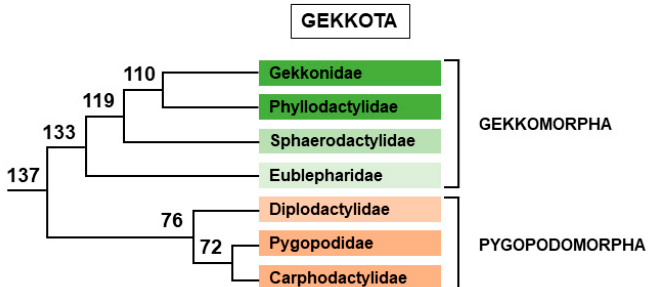
Figure 10. Phylogenic tree of Gekkota. Relative positions of each family are represented. Branch lengths are not proportional to time. Numbers indicate divergence time (Myrs) from present for nodes, according to [38]. Color of each family indicates the different clades.